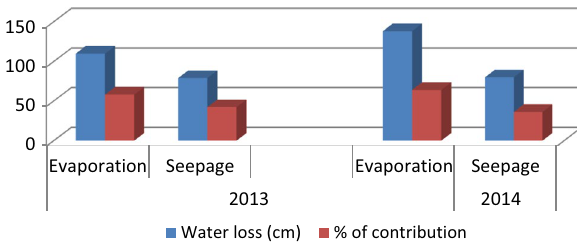
Fig. 6 Evaporation and seepage and their contribution in water loss percentage during 2013 and 2014